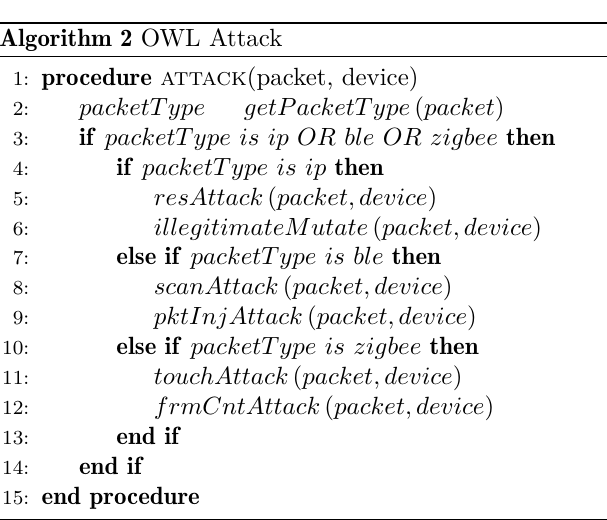
Algorithm 2 OWL Attack